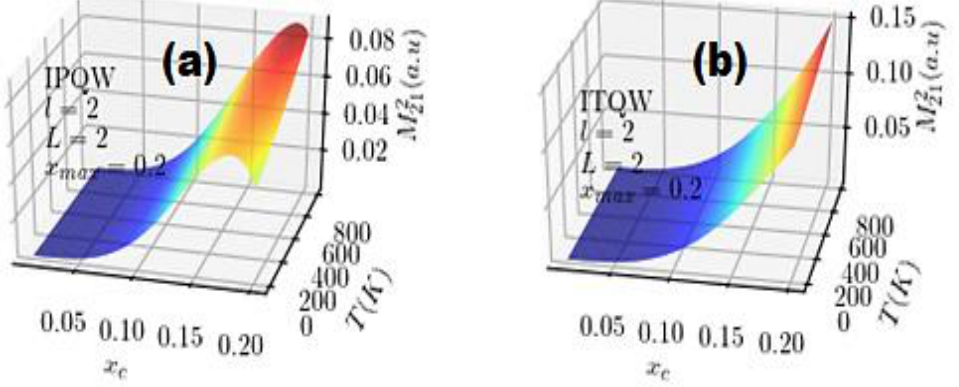
Figure 5: The variation of the electric dipole transition moment in both ITQW (a) and IPQW (b) and versus the In-compositions (x-axis) and temperature (y-axis) with a fixed barrier/well width (L=l=2) and x max